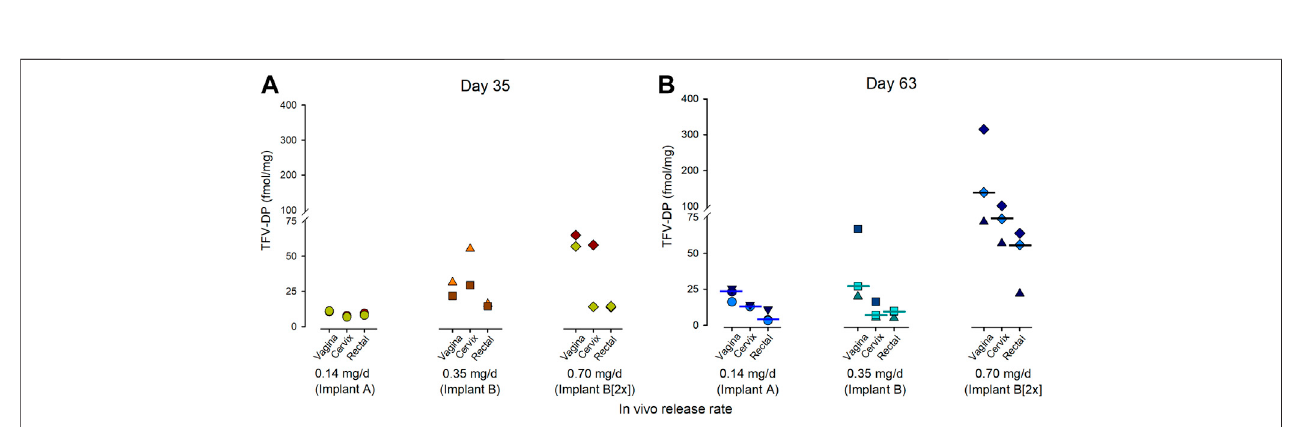
FIGURE 4 | Concentrations of TFV-DP in the vaginal, cervical, and rectal tissues resulting from a TAF implant lasting 35 days (A) or 63 days (B) in the NZW rabbit. The data point corresponds to individual animals from each treatment group. The bar indicates the median TFV-DP concentrations.